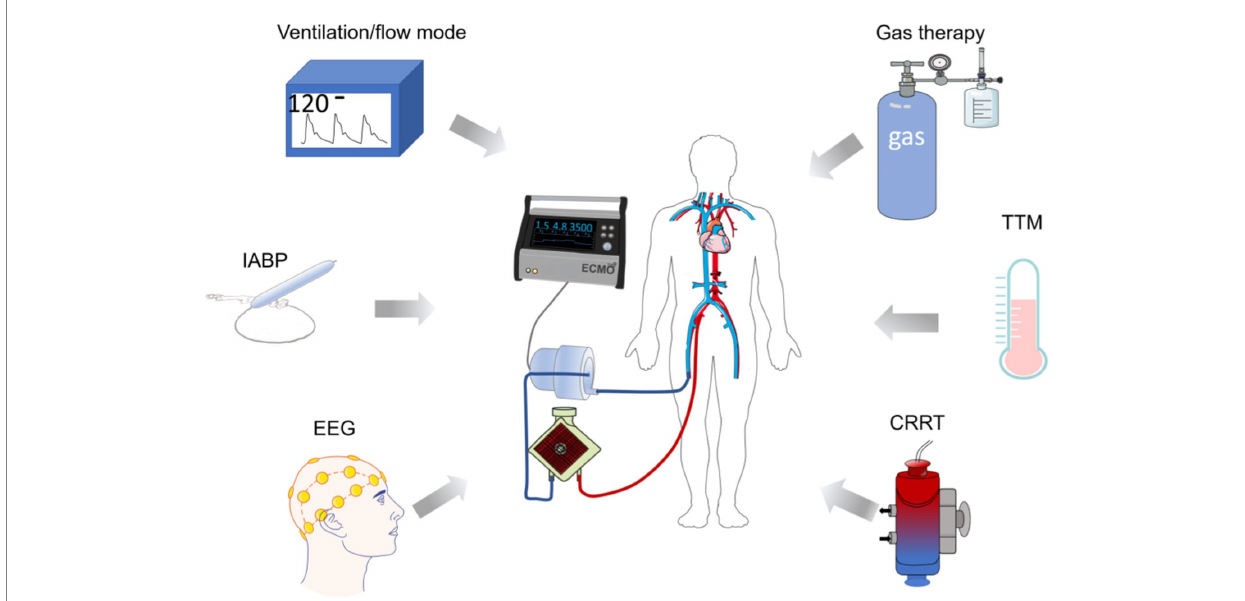
FIGURE 3 Diagram of ECMO in combination with other means of neuroprotection. The diagram indicates hemodynamic control, IABP, and EEG utilized during the treatment, respectively. Target temperature management, appropriate gas (H 2 , CO) interventions, and CRRT can assist in mitigating ECMO-related brain complications and provide ideas for neurological prognosis after ECMO use. TTM, target temperature management; CRRT, continuous renal replacement therapy; IABP, INTRA-aortic balloon